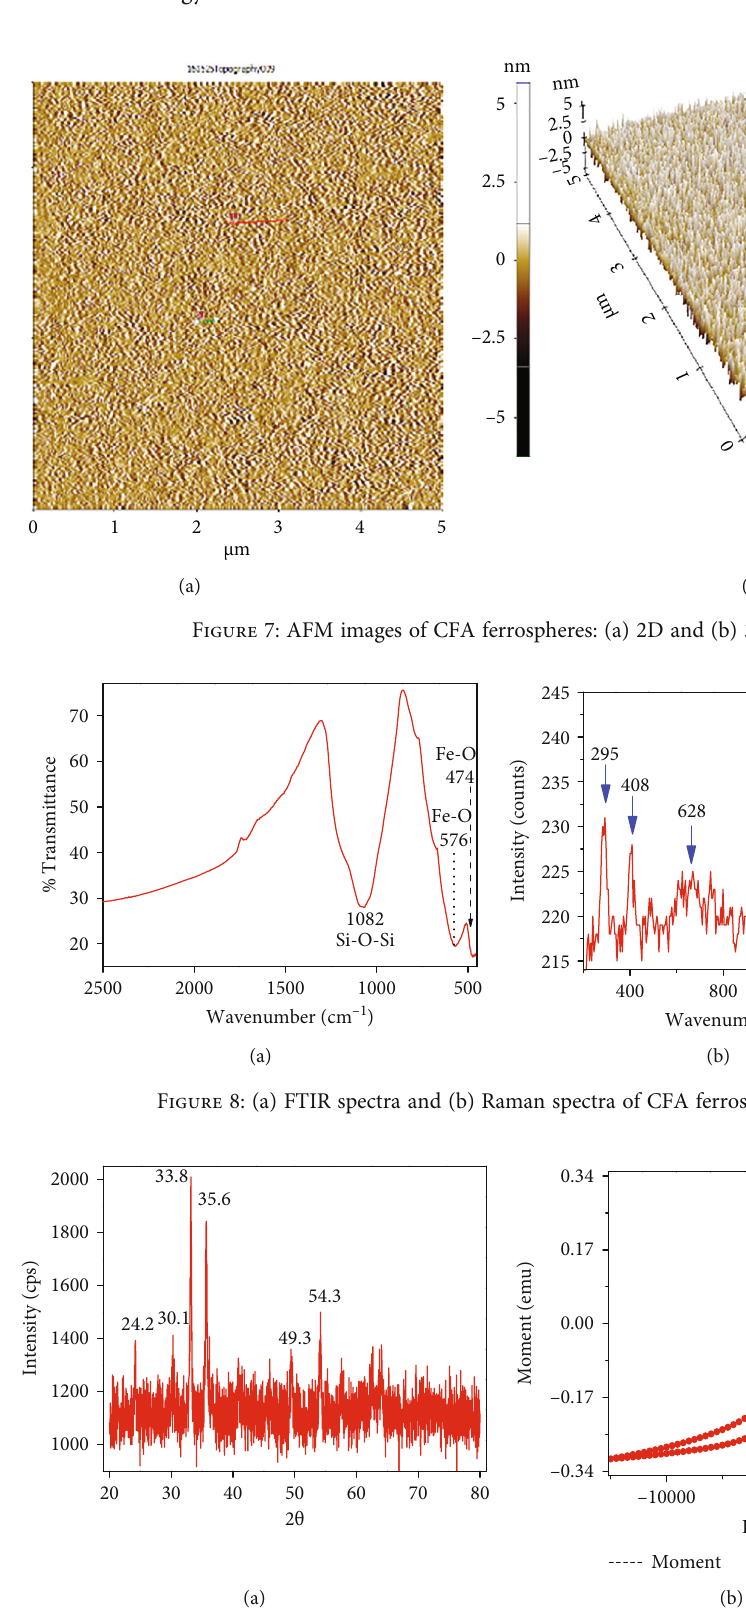
Figure 9: (a) XRD di ff ractograms of ferrospheres and (b) magnetic strength of ferrospheres by